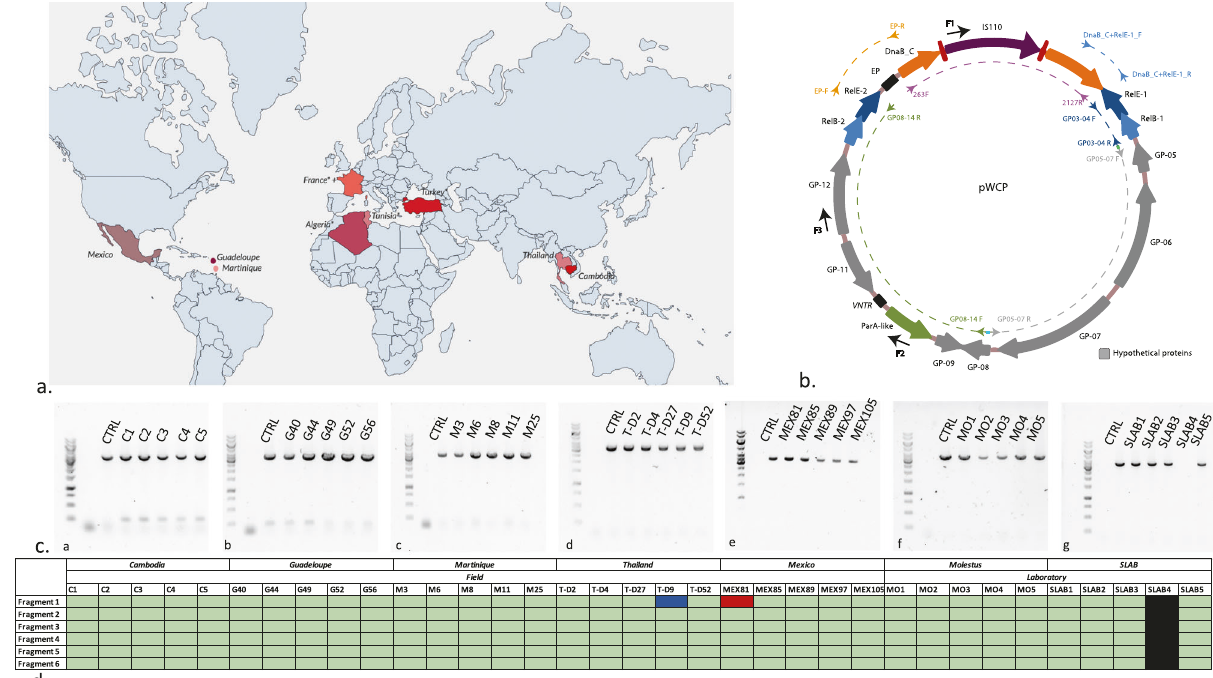
Fig. 1 pWCP distribution and sequence variability. a Geographic map with locations of Culex sample collection for pWCP screening. Colors indicate fi eld samples with different color for each country sampled. A “ + ” indicates laboratory specimen and “ * ” indicates previous observations from [14]. b Map of pWCP plasmid (adapted from [14]). Genes are shown as fi lled arrows. Couples of PCR primers spanning different regions of the plasmid designed to cover pWCP are shown as smaller arrows. Dash lines indicate ampli fi ed fragments (Purple: Fragment 1; Dark blue: Fragment 2; Gray: Fragment 3; Green: Fragment 4; Orange: Fragment 5; Light blue: Fragment 6). Bright green and blue dots indicate overlapping primers as highlighted in Supplementary Table 2. Additional sequencing primers are shown in black arrows on the outer layer. c PCR ampli fi cation of the largest and most representative for plasmid genetic diversity Fragment 4 in studied samples. A ca. 3451 bp PCR product corresponding to the ampli fi cation of Fragment 4 including seven genes of pWCP (GP08, GP09, ParA-like, VNTR, GP11, GP12 and RelBE-2) in most ovary samples collected from different regions. a: Cambodia, b: Guadeloupe, c: Martinique, d: Thailand, e: Mexico, d: Montpellier (molestus) and f: SLAB. The fi rst raw of each gel is the negative CTRL. d Synthetic heatmap of conserved pWCP fragments across samples. pWCP fragments 1 – 6 are shown in row and studied samples in column. Green color indicates fragment of the right size, blue if longer, red if shorter. Black corresponds to Wolbachia -free